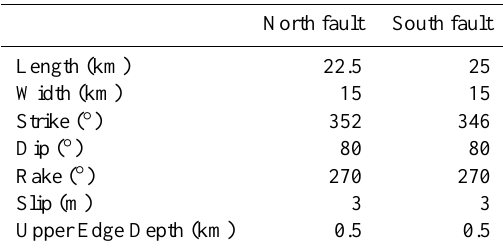
Table 2. Benchmark 1: mean ( ¯ R ) and root mean square (RMS) of − θ C the residuals θ T for shoreline position and velocity calculated i i over 400s simulation time. The residuals are plotted in Fig.